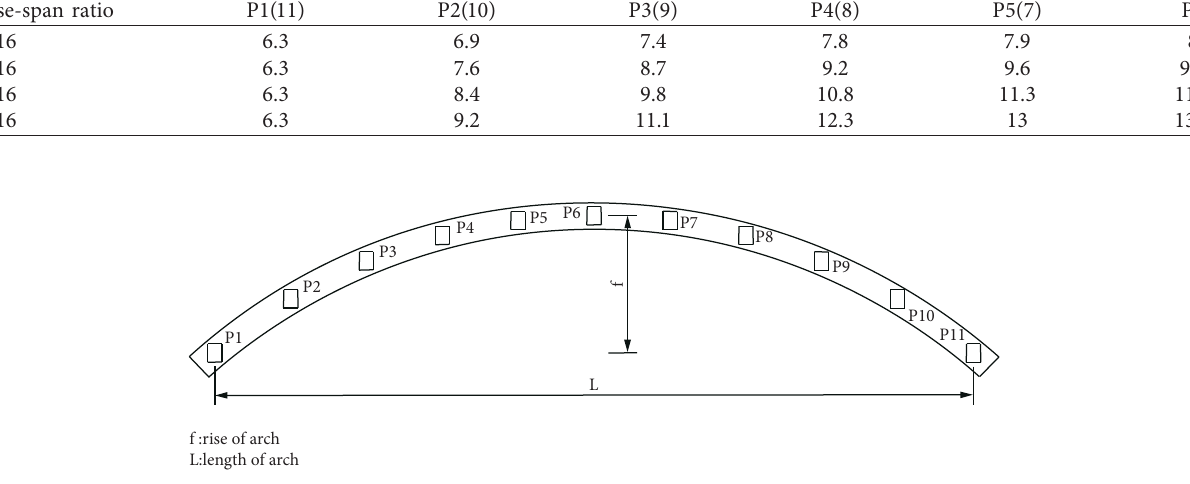
Figure 2: Layout of piles and coupling